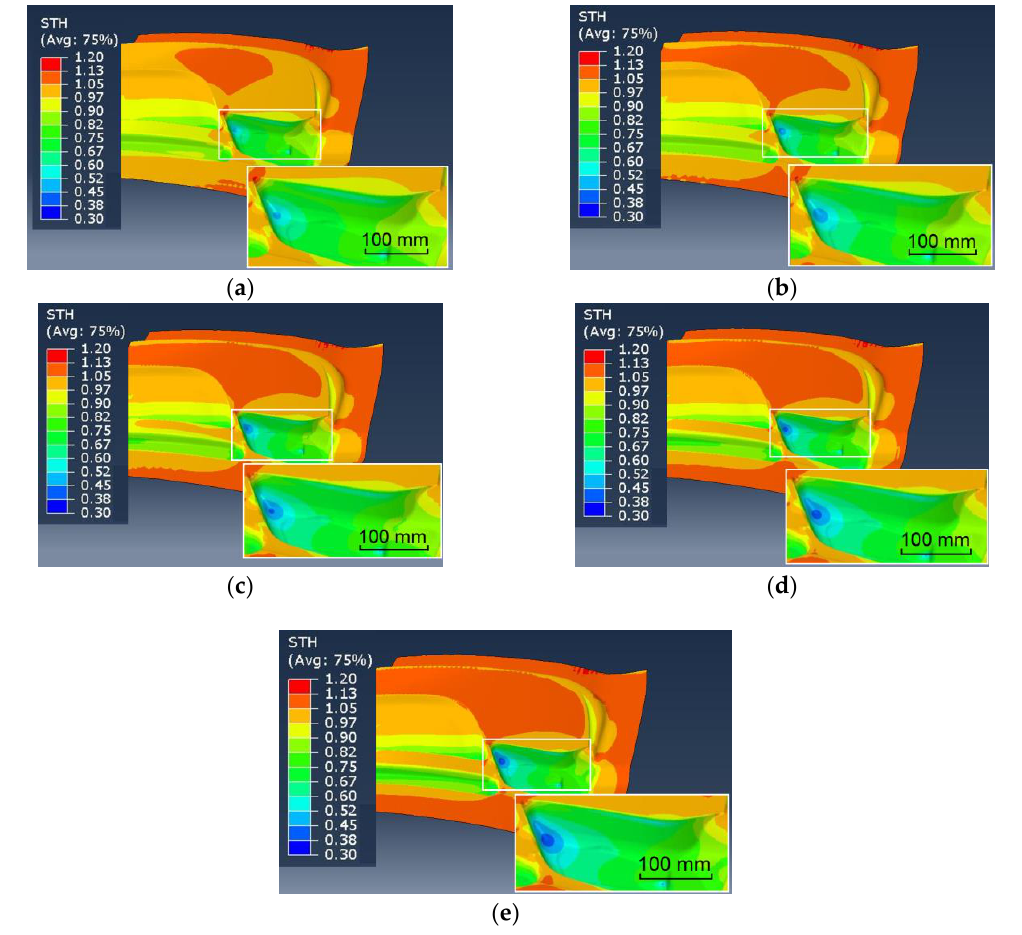
Figure 9. Predicted thickness variation within the part deformed with gas profile #3 (t: 120 s) assuming friction coefficient of: ( a ) 0.1; ( b ) 0.15; ( c ) 0.2; ( d ) 0.25; and ( e ) 0.3.